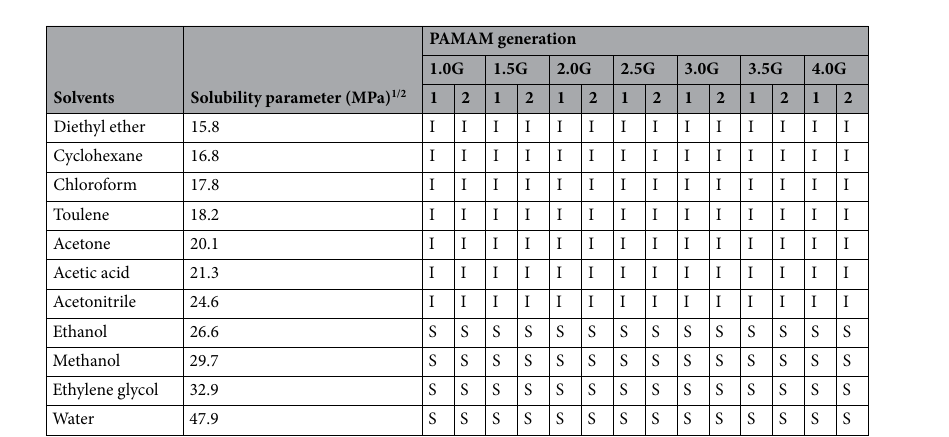
Table 3. Solubility of different generations of polyamidoamine dendrimer in some common solvents. *1-Solubility 15 min after addition of solvent; 2-Solubility after 36 h of tumbling; I Insoluble S Soluble.